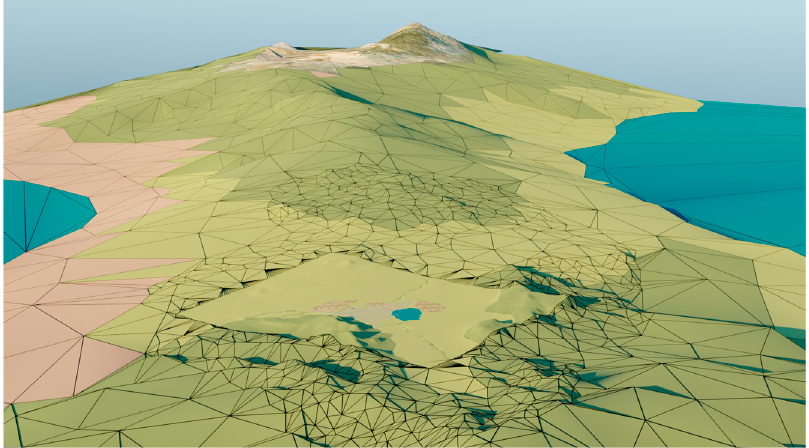
Figure 14. Extended 3D terrain model surrounding the 3D terrain model of San Cristóbal de La Laguna in Figure 13.